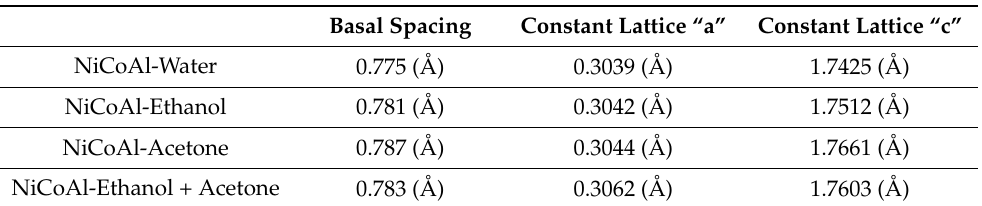
Table 3. Calculated basal spacing and lattice constants “a” and “c” for NiCoAl-Water, NiCoAl-Ethanol, NiCoAl-Acetone, and NiCoAl-Ethanol +